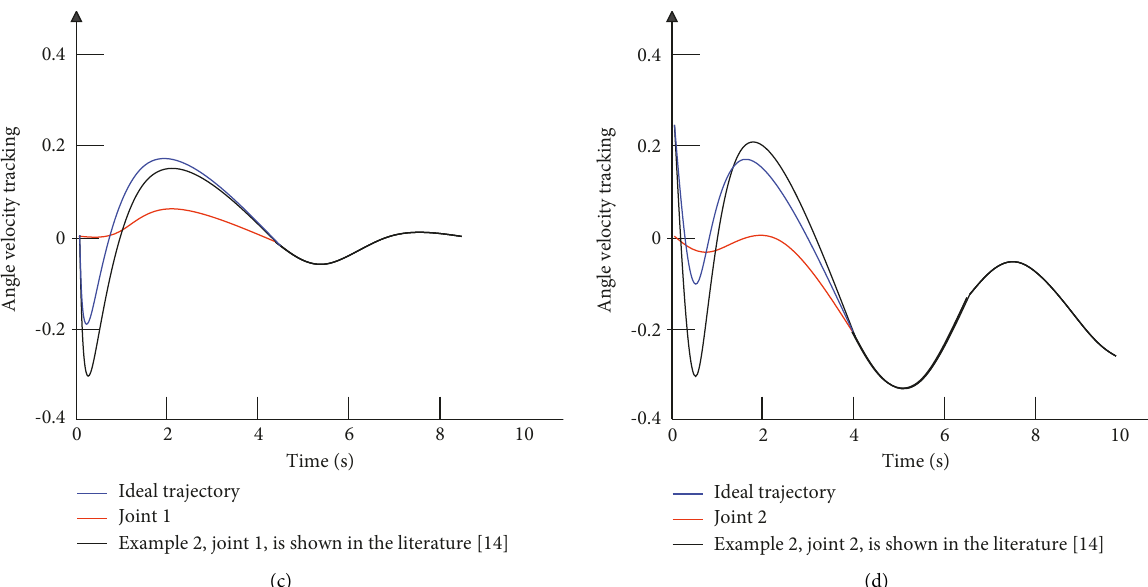
Figure 6: Simulation curve of angular displacement and angular velocity of joint manipulator. (a) Joint 1 angle tracking, (b) Joint 2 angle tracking, (c) Joint 1-angular velocity tracking, (d) Joint 2-angular velocity